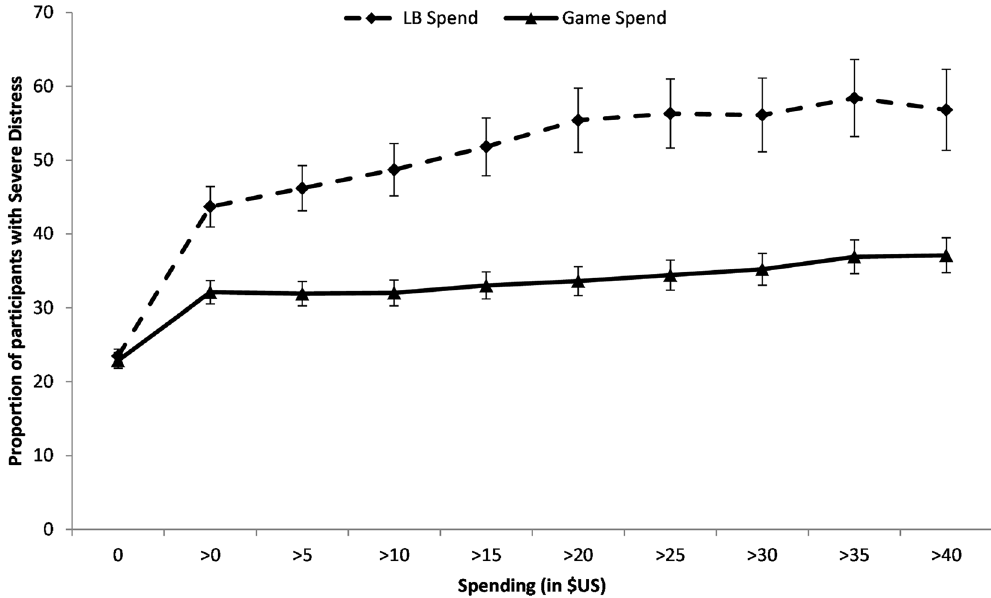
Figure 2. Prevalence of severe psychological distress (K-10 > 30) for those who spent more than a given amount on loot boxes and video games. Error bars represent 95%